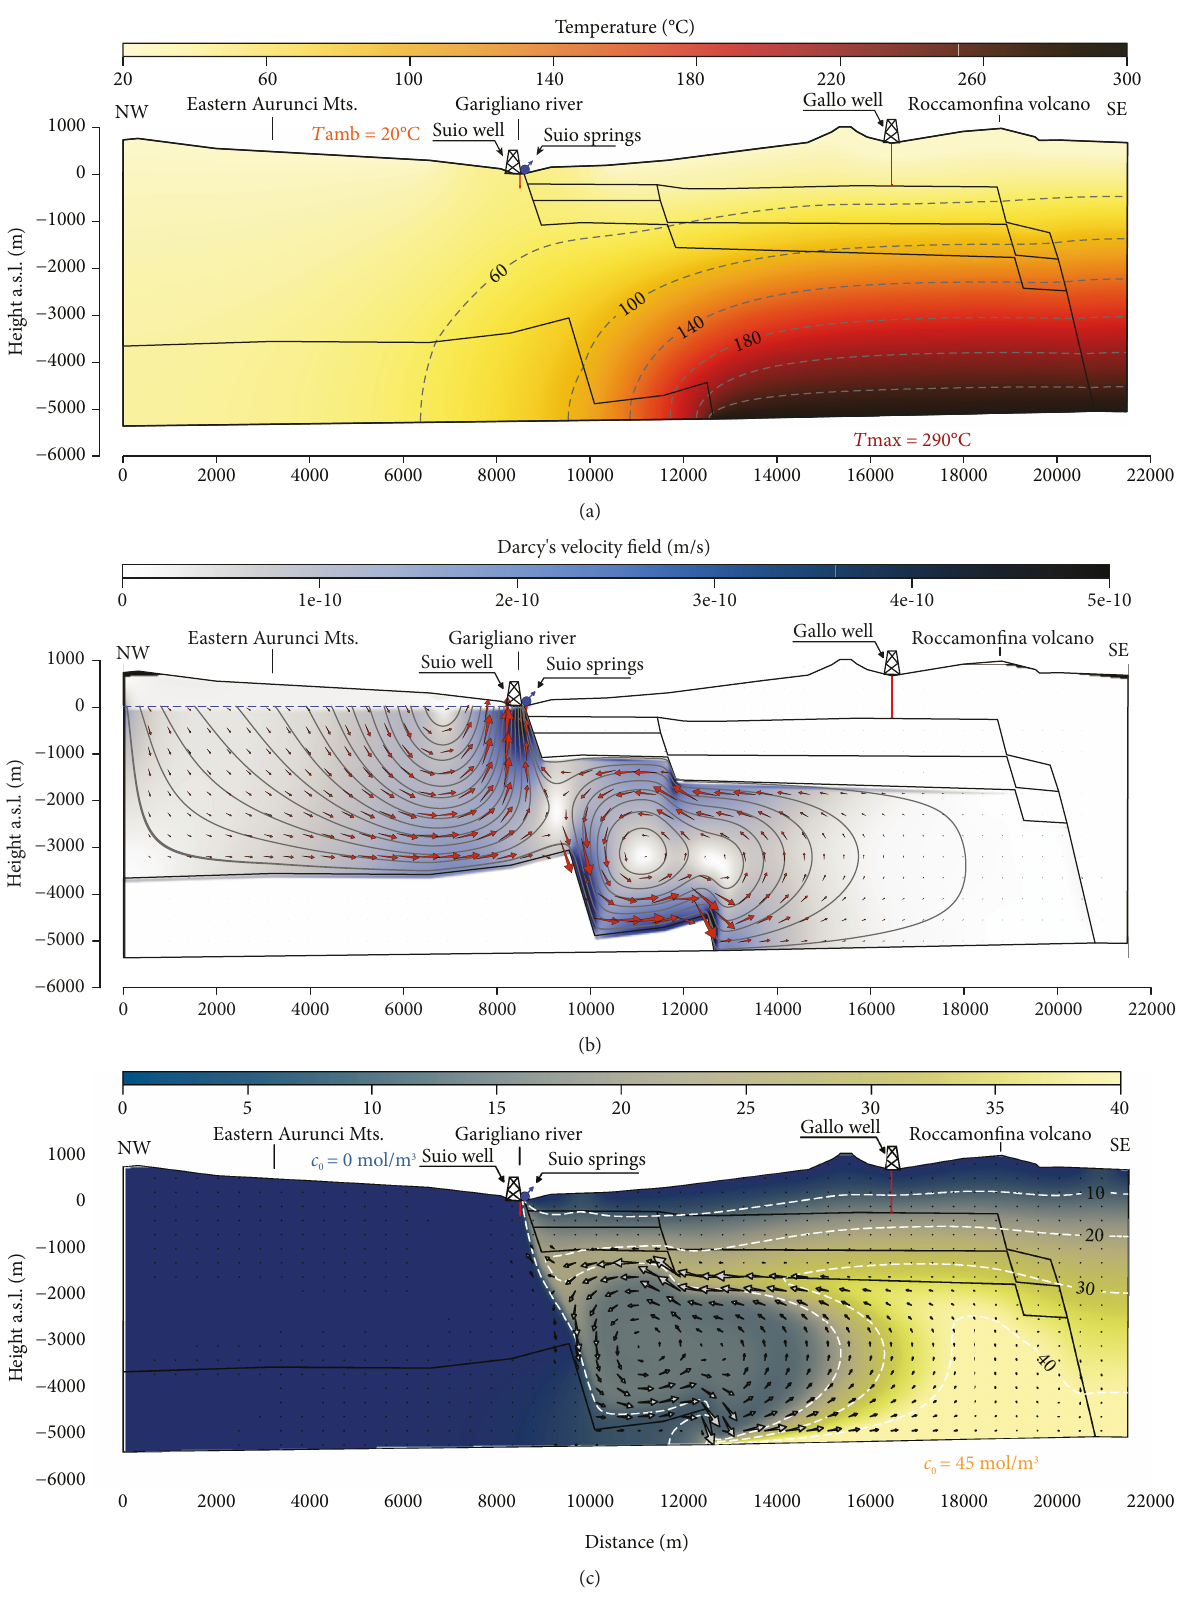
Figure 8: Main results from the steady-state numerical model with optimal parameters. (a) Temperature distribution inside the modelled cross section. (b) Fluid fl ow velocity (the coloured pattern), path (the grey curves), and direction (the red arrows) inside the CC complex. (c) The concentration of dissolved gas, with the grey arrows showing the steady-state convective fl